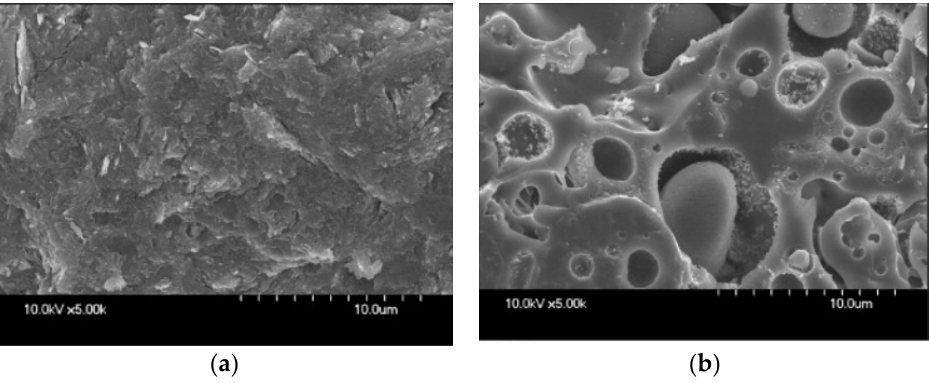
Figure 5. SEM micrographs of MGC ( a ) and FGC ( b ) microstructures (reproduced with permission from Kong et al., Cement and Concrete Research ; Elsevier, 2007).